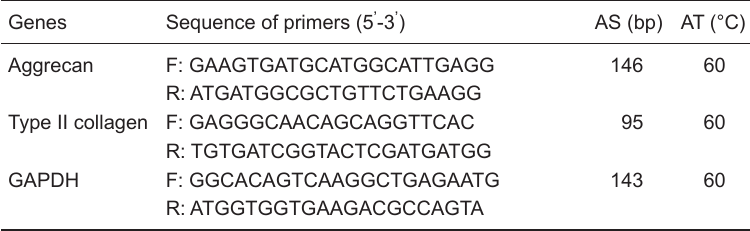
Table 1. Primer sequences and product sizes used in real-time